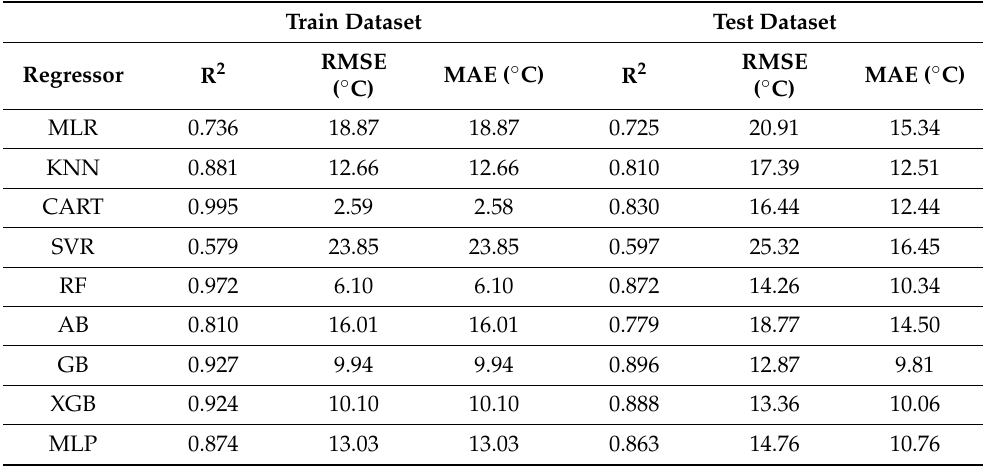
Table 1. Scores (R 2 , RMSE and MAE) obtained in the train and test datasets for the nine algorithms implemented without tuning. MLR: multiple linear regression. KNN: k-nearest neighbors. CART: classification and regression tree. SVR: support vector regression. RF: random forest. AB: AdaBoost.